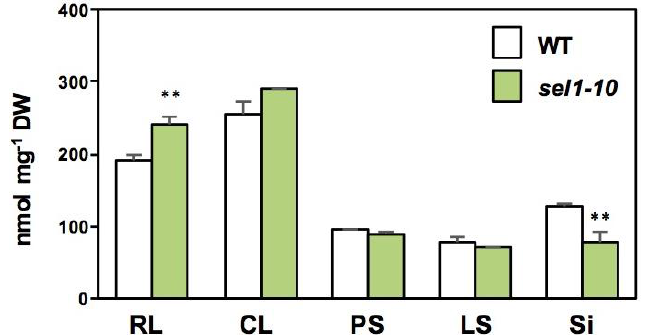
Figure 2. Sulfate concentrations in different parts of WT and sel1-10 plants . Sulfate content in each part was determined by ion chromatography. WT and sel1-10 seedlings were grown for six weeks in vermiculite, and each part was harvested. Rosette leaves (RL), cauline leaves (CL), primary stems (PS), lateral stems (LS), and siliques (Si). White and green bars represent the sulfate content in WT and sel1-10 , respectively. Data are shown as averages with error bars denoting SEM (n = 3). Asterisks indicate significant differences (Student’s t -test; * 0.05 < p < 0.1, ** p < 0.05) between WT and sel1-10 plants.